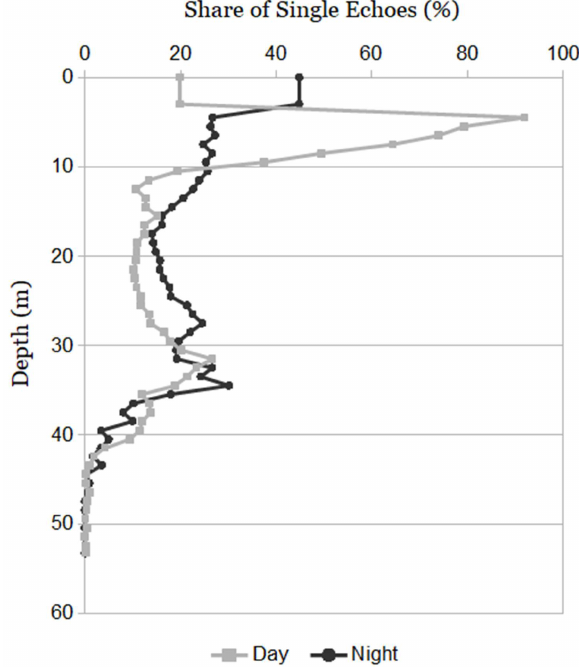
Figure 3. Di ff erences in share of single echoes (%) between di ff erent layers as well as measurement Figure 3. Differences in share of single echoes (%) between different layers as well as measurement acquisition time (daytime, acquisition time (daytime, nighttime).